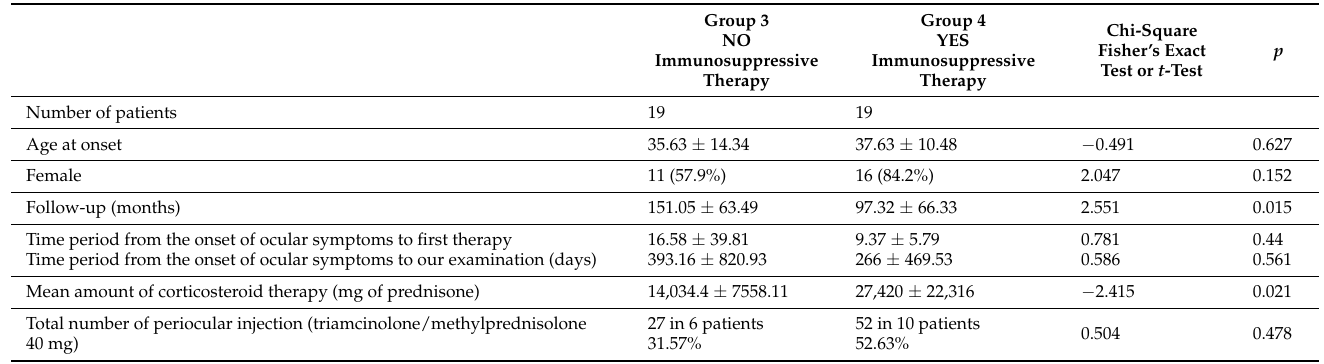
Table 3. Demographics and clinical features of patients with Vogt–Koyanagi–Harada disease, accord- ing to the administration of immunosuppressive drugs during